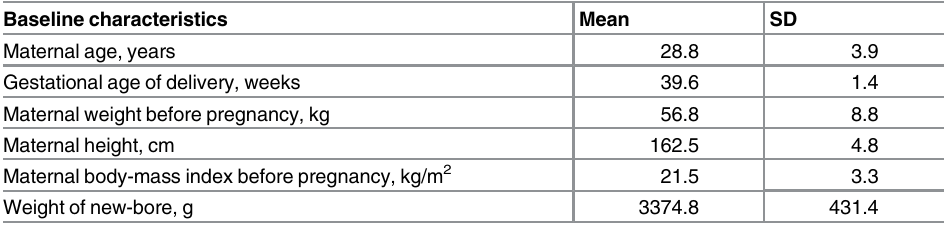
Table 2. The demographic characteristics of pregnant women enrolled in this